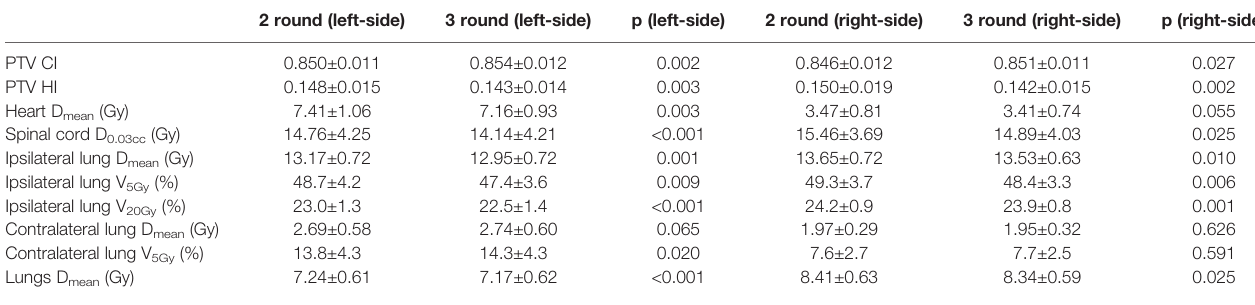
TABLE 9 | Dosimetric results (mean ± standard deviation) of postmastectomy VMAT plans with 2 round and 3 round optimizations. 2 round (left-side) 3 round (left-side) p (left-side) 2 round (right-side) 3 round (right-side) p (right-side)